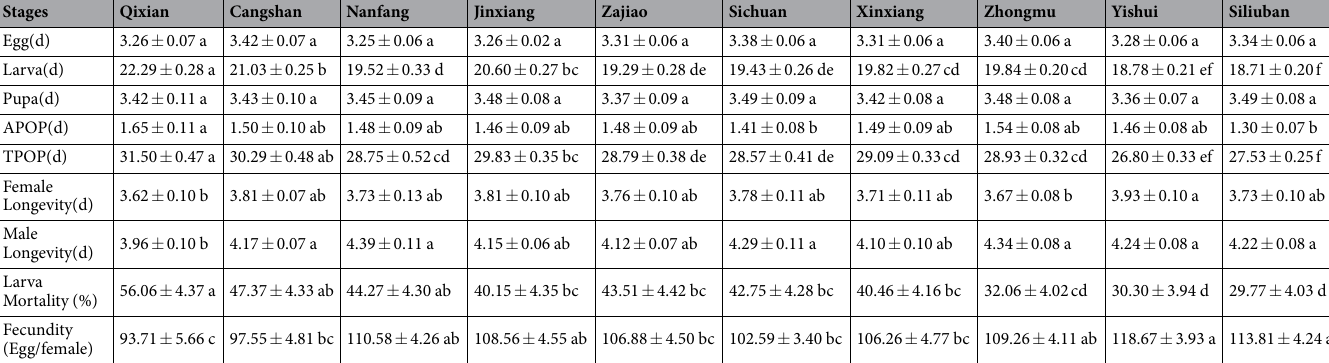
Table 1. Life tables of Bradysia odoriphaga on 10 cultivars of garlic. APOP, adult preovipositional stage; TPOP, total preovipositional stage (from egg to first oviposition). The values (mean ± s.e.) and standard errors were calculated using the bootstrap procedure with 10,000 bootstraps. The means followed by different letters in the same column are significantly different between cultivars at 5% significance level using the paired bootstrap test included in the computer program TWOSEX-MS